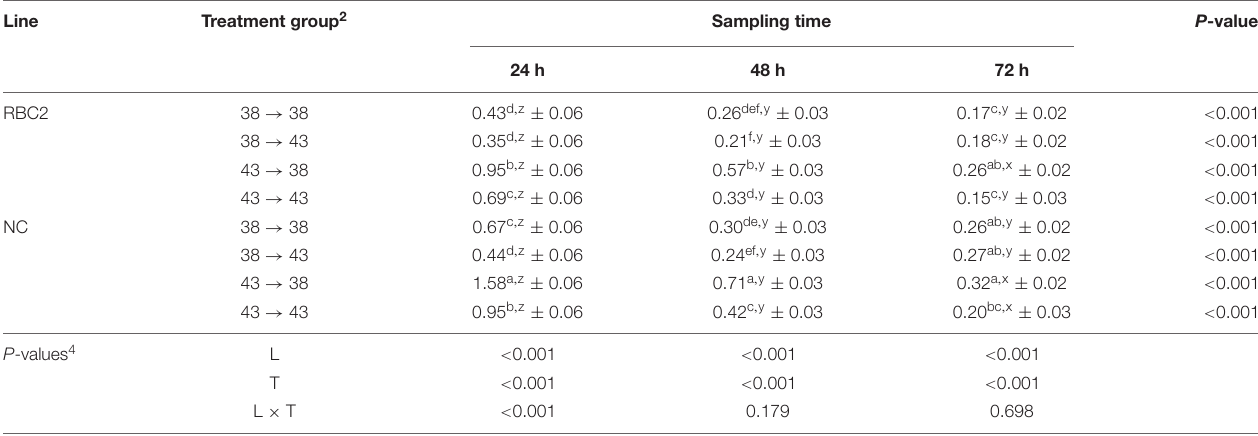
TABLE 5 | Effect of heat stress (43 ◦ C) on lipid accumulation during differentiation of satellite cells isolated from the pectoralis major muscle of Randombred Control Line 2 (RBC2) and Nicholas Commercial (NC) line turkeys 1 . Line Treatment group 2